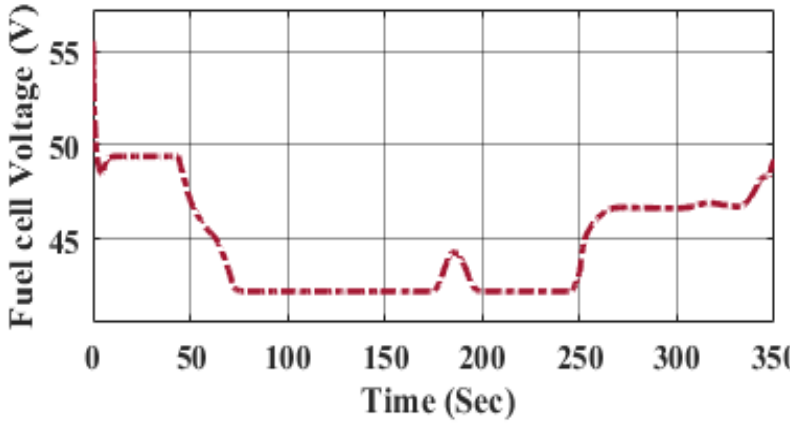
Figure 18. Variation in fuel cell input voltage.